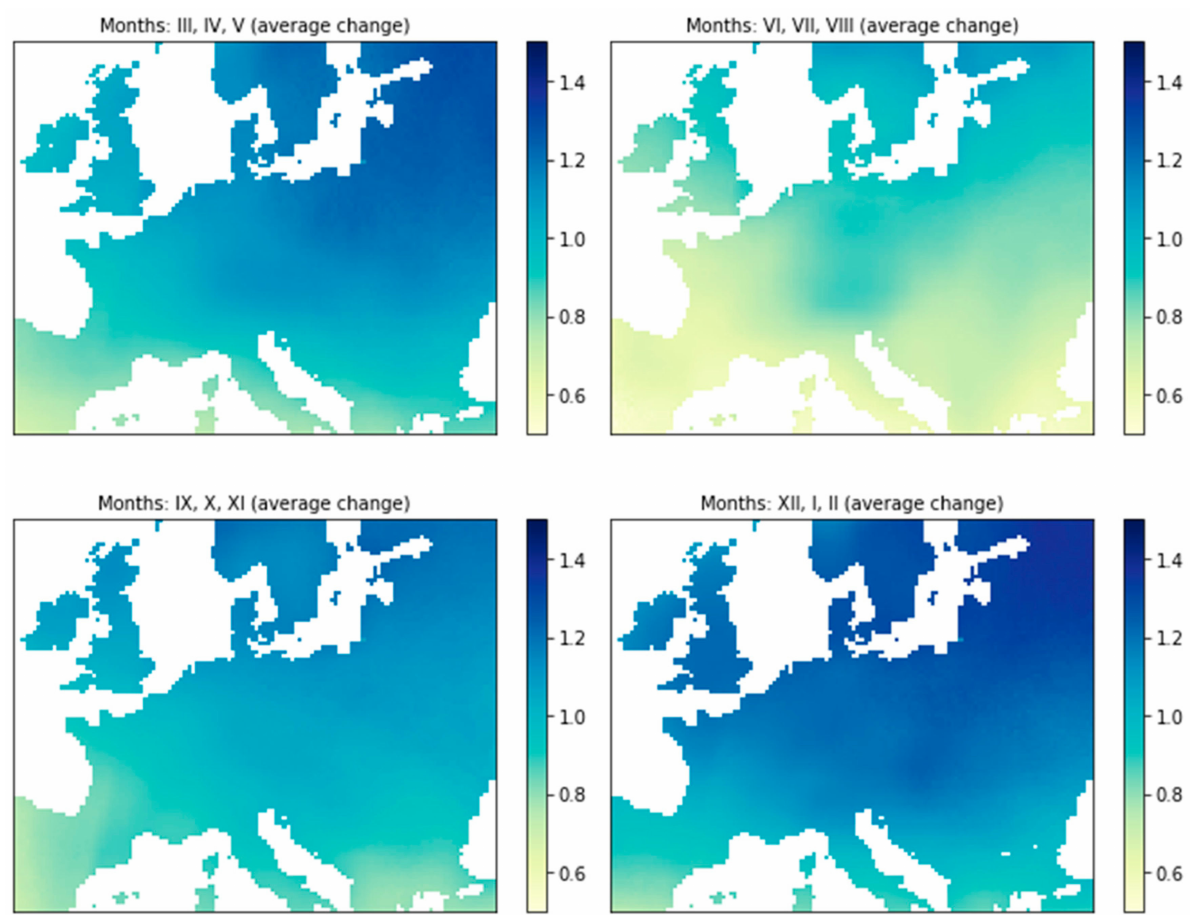
Figure 1. The derived average change of monthly precipitation (ratio) over Europe for scenario